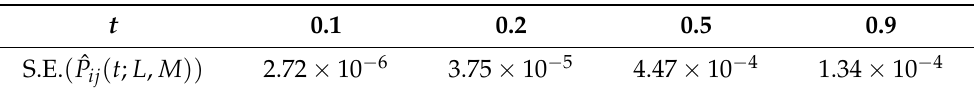
Table 5. Squared errors (S.E.) for the estimators of the semi-Markov transition probabilities in the case of no censoring.